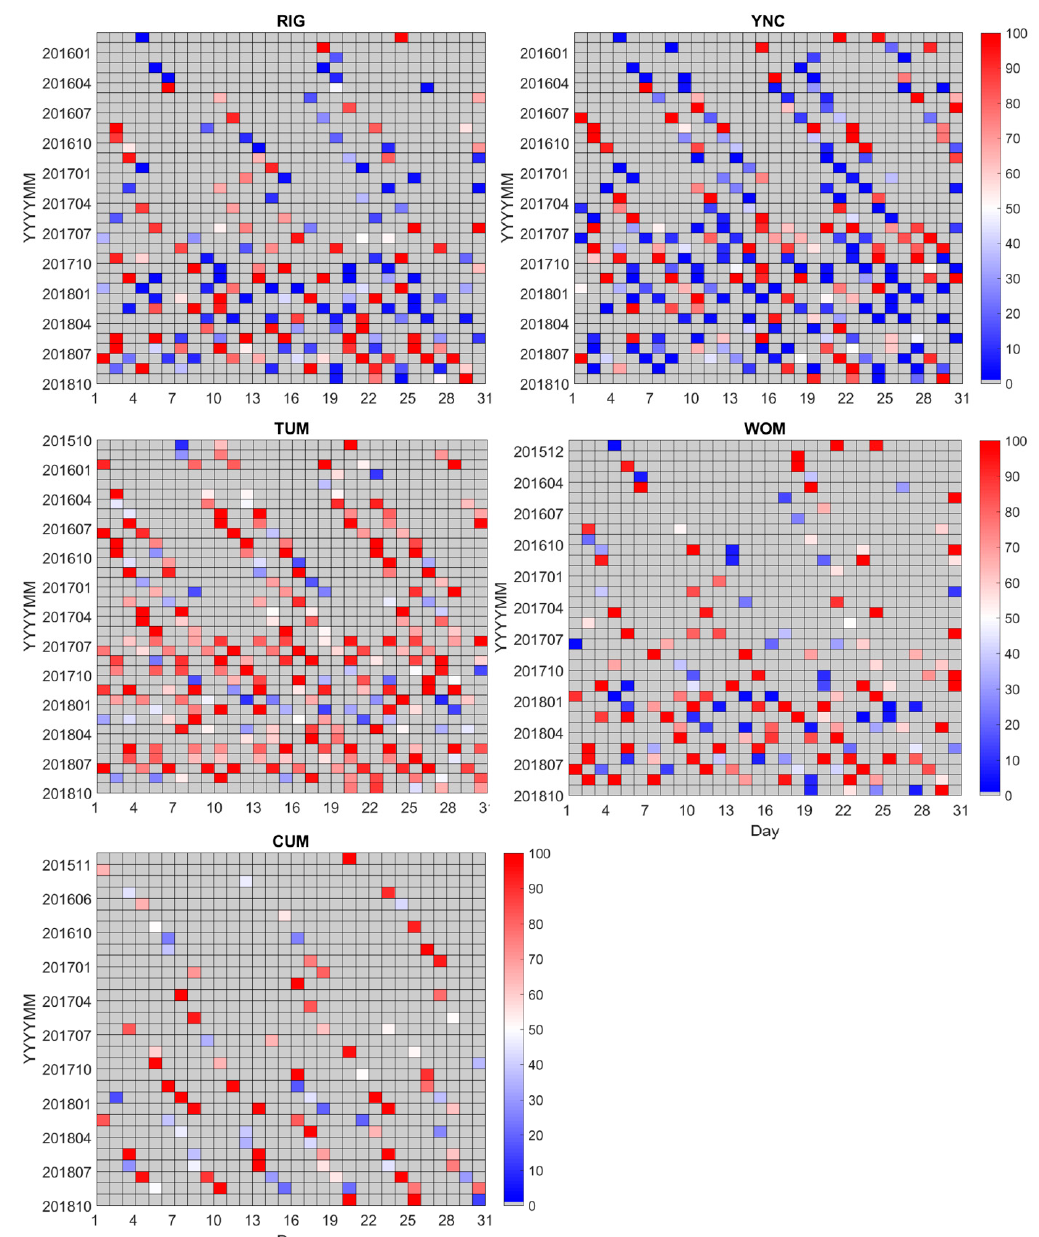
Figure 2. Cloud cover fractions of Sentinel-2 images of the coordinate tile at each site. The y -axis is the month tag in (YYYYMM; Y = year, M = month) since the launch of Sentinel-2A, and the x -axis is the day of that month. The color bar represents the percentage of clouds in the image.